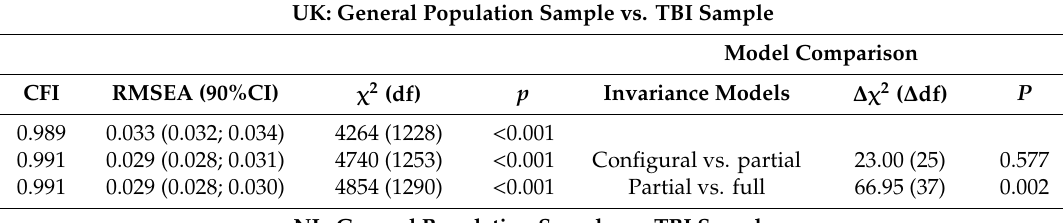
Table A4. Results of measurement invariance